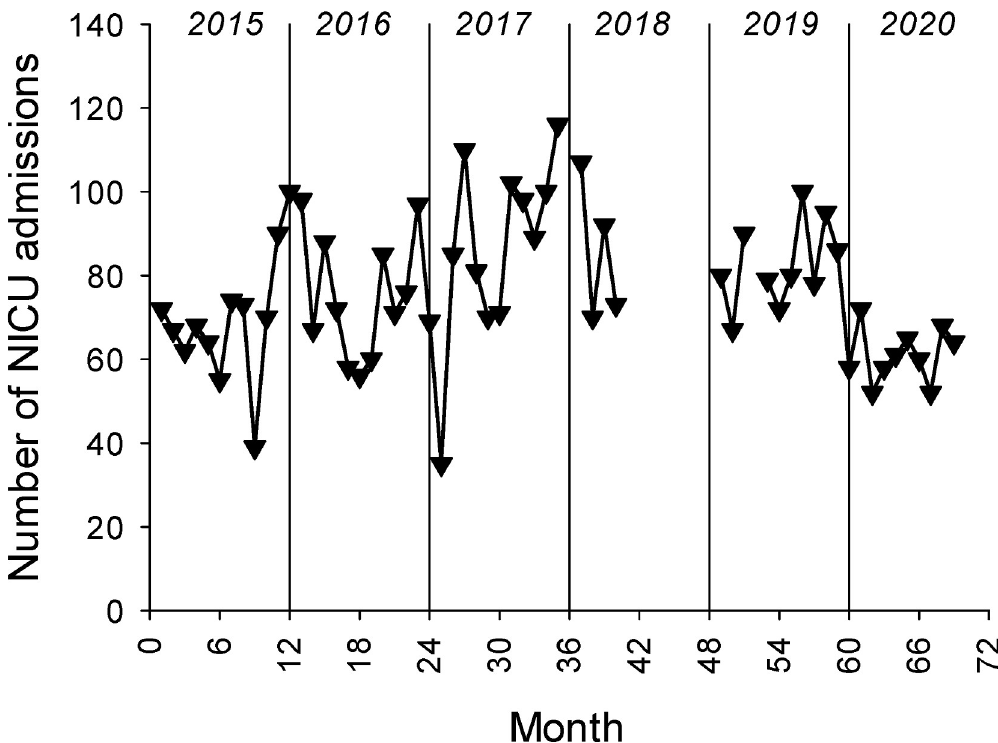
implementation (1 st 3 quarters of 2015) the mean monthly admissions were 64 ± 11 and for the period following NICU implementation the mean monthly admissions were 77 ± 17, p =